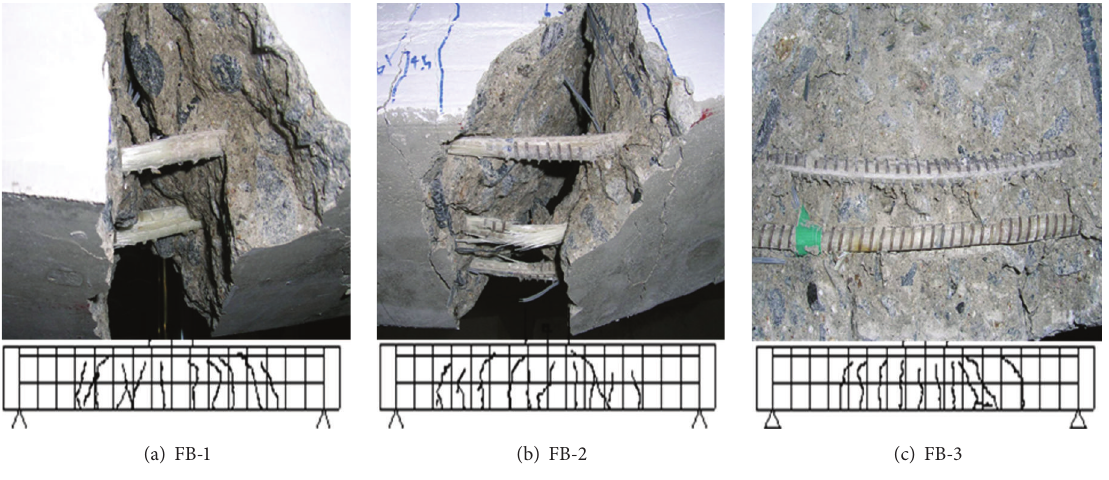
Figure 3: Flexural failure and crack patterns of FB-1, FB-2, and FB-3.